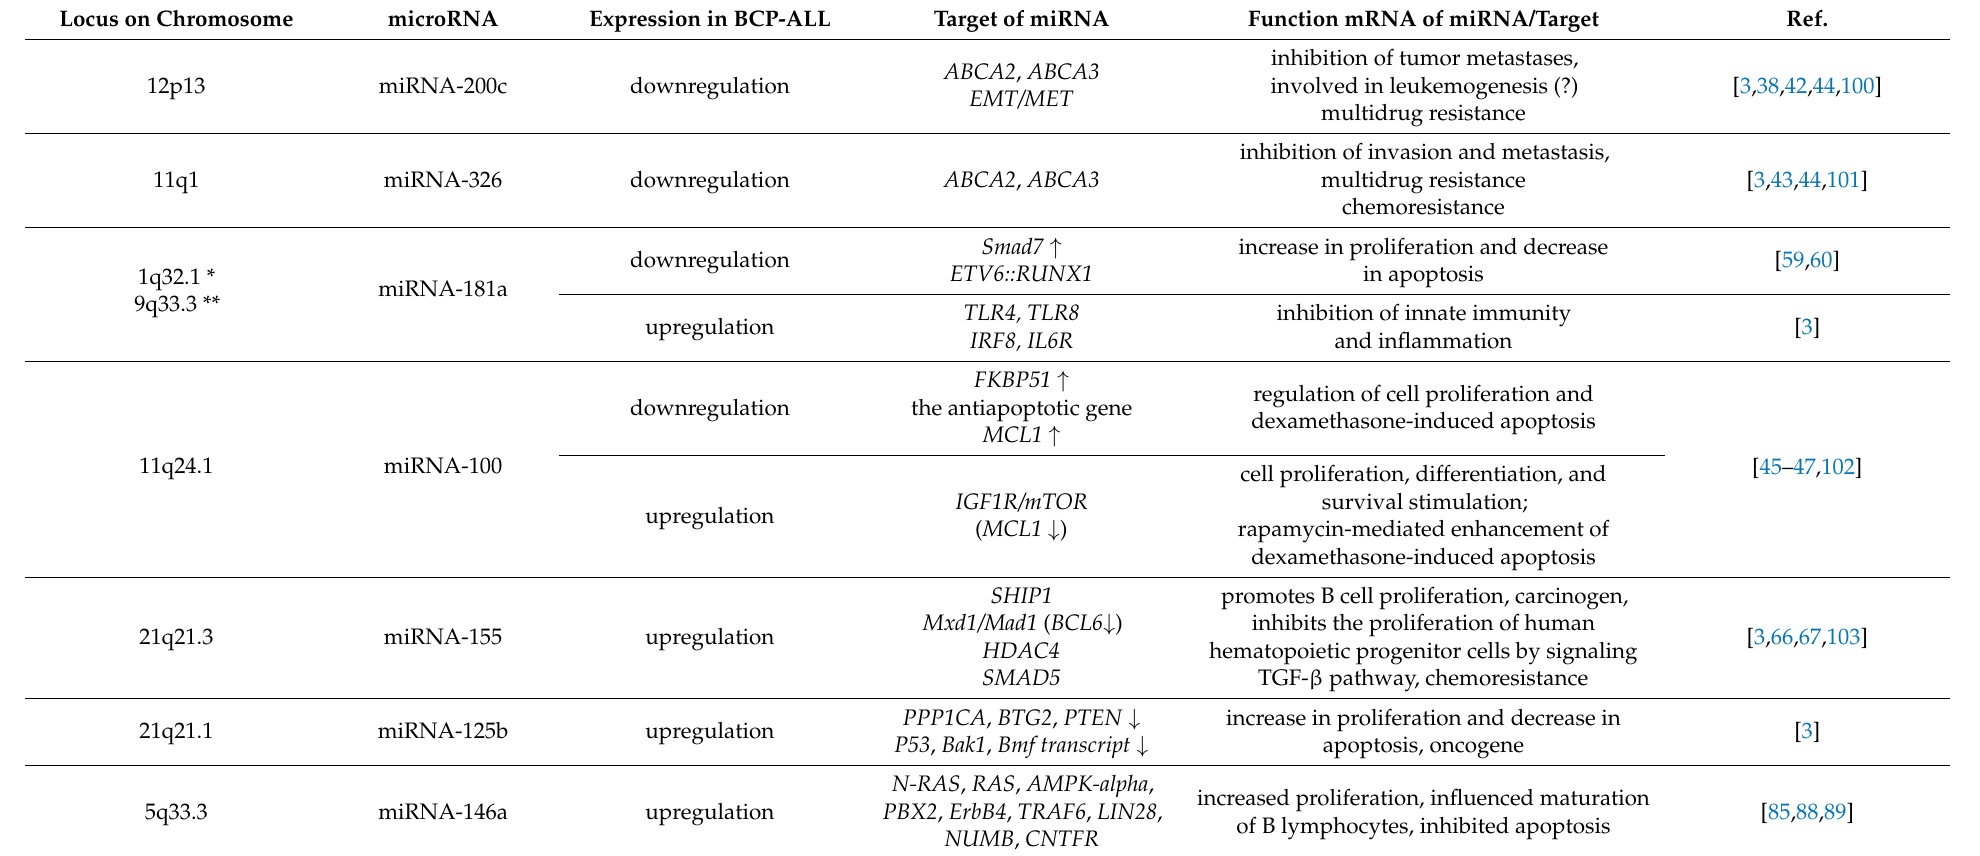
Table 1. The characteristics of selected miRNAs in childhood